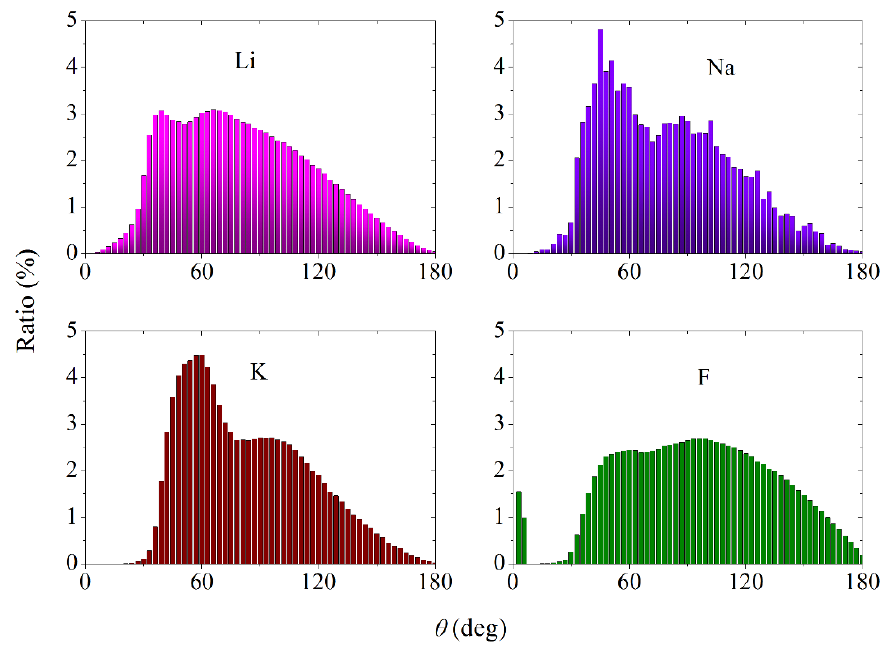
Figure 12. Angular distributions of nearest geometric neighbors for the Li, Na, K and F subsystem of molten salt mixture FLiNaK+CeF 3 at a temperature of 950 K.